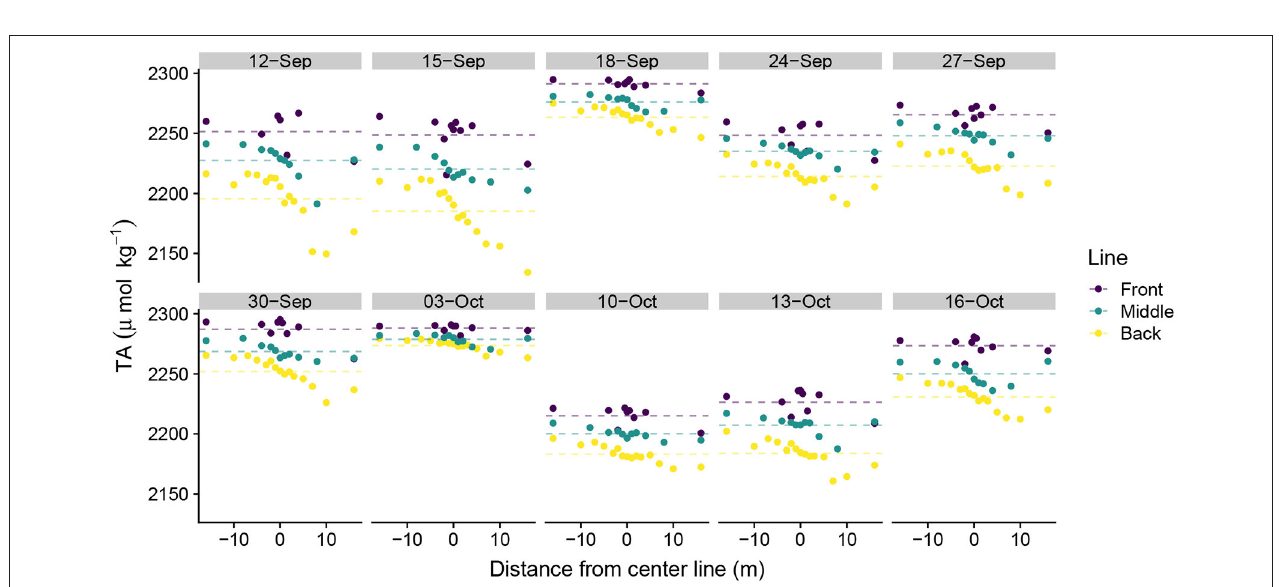
FIGURE 4 | Spatial distribution of total alkalinity measurements. Spatial distance values less than zero are located north of the center line and distance values greater than zero are located south of the center line in Figure 1 . Dotted lines show line-averaged TA.